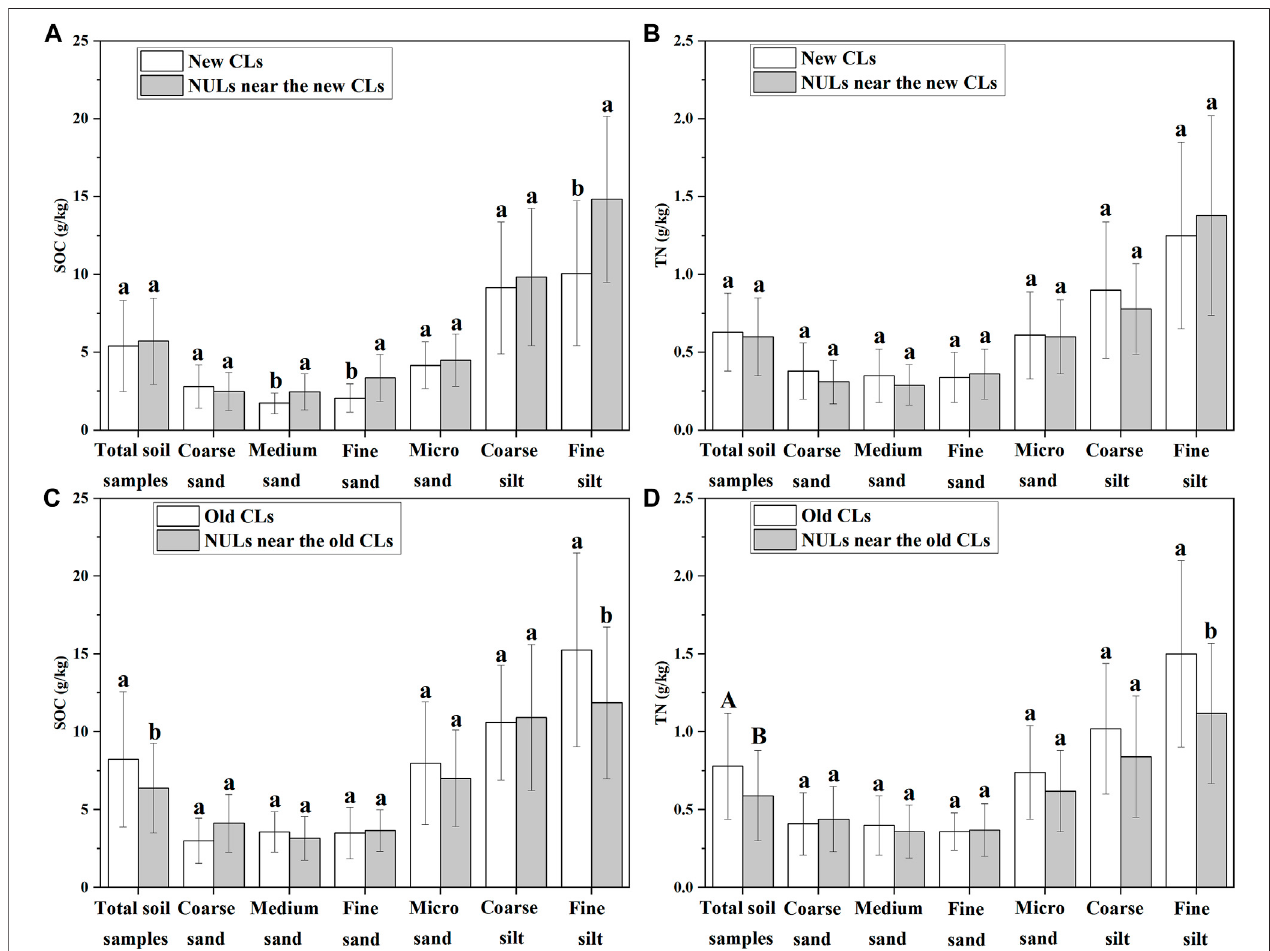
FIGURE 4 | (A,B) SOC and TN contents in the different particle diameter groups in the new CLs and NULs; (C,D) SOC and TN contents in the different particle diameter groups in the old CLs and NULs. The upper and lowercase letters denote the differences in the SOC and TN contents between the CLs and corresponding NULs based on paired-sample t -tests at con fi dence levels of 0.01 and 0.05, respectively.